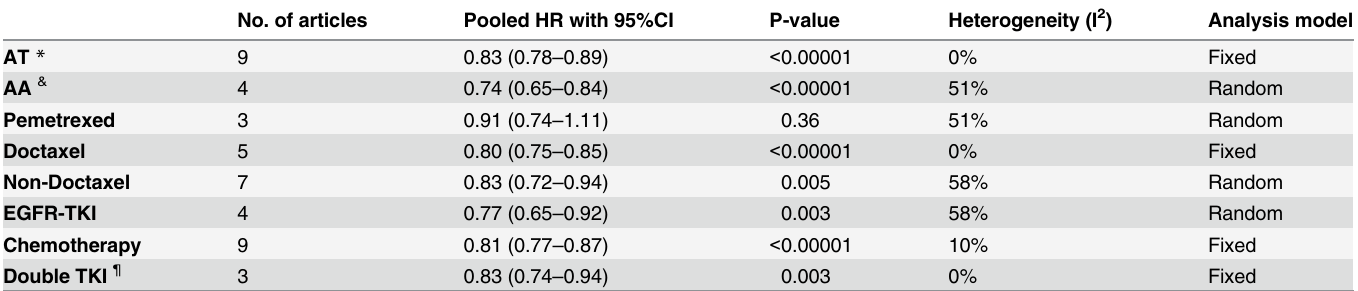
Table 4. Summary of the subgroup results: Pooled HR & 95%CI for PFS and the corresponding details. No. of articles